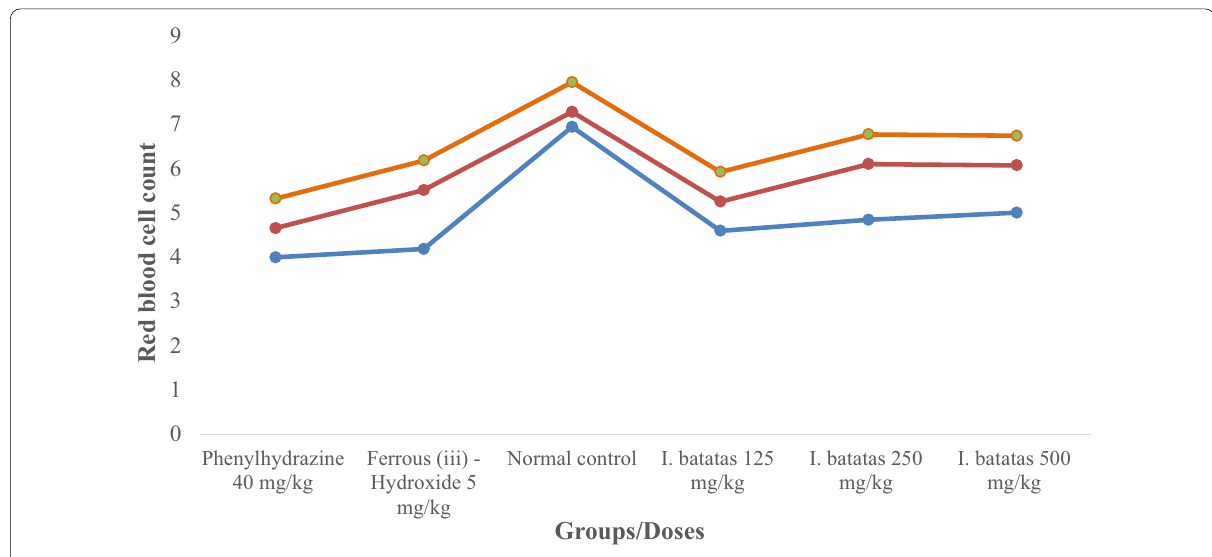
Fig. 2 Effect of n-hexane leaves extract of Ipomoea batatas on red blood cell count in rats. Blue—day 1, Red—day 7, Orange—day 14